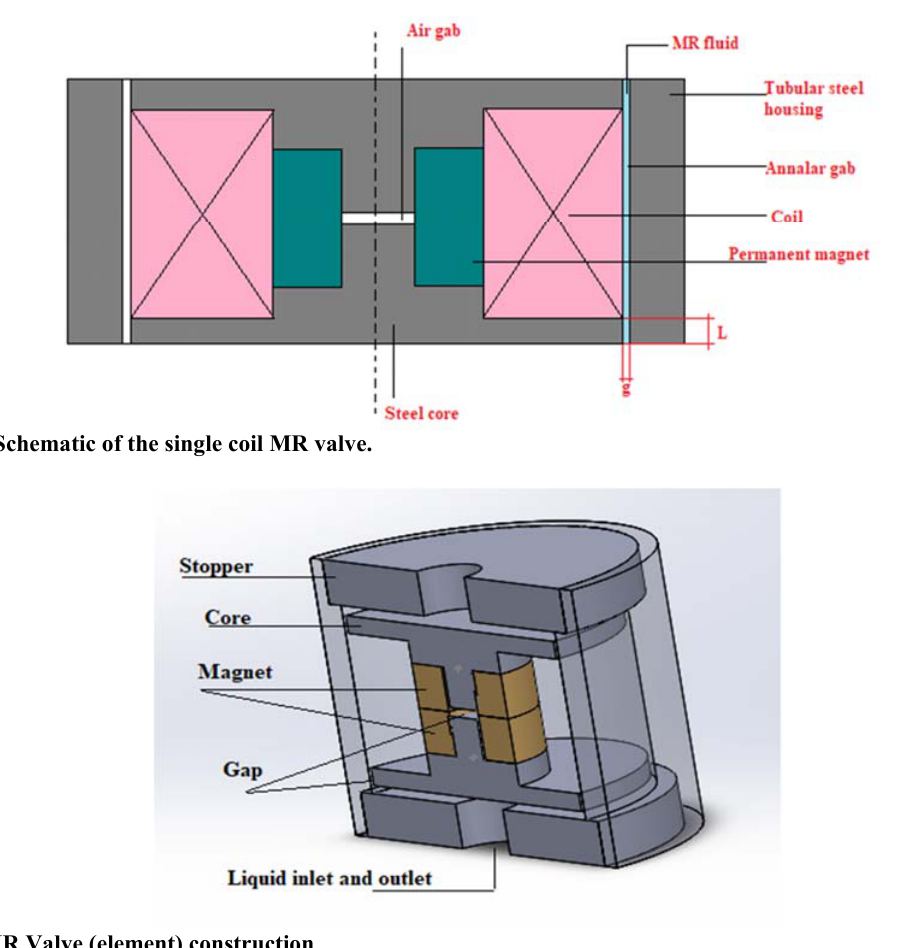
Fig. 1. Assembly of singular MR Valve (element).